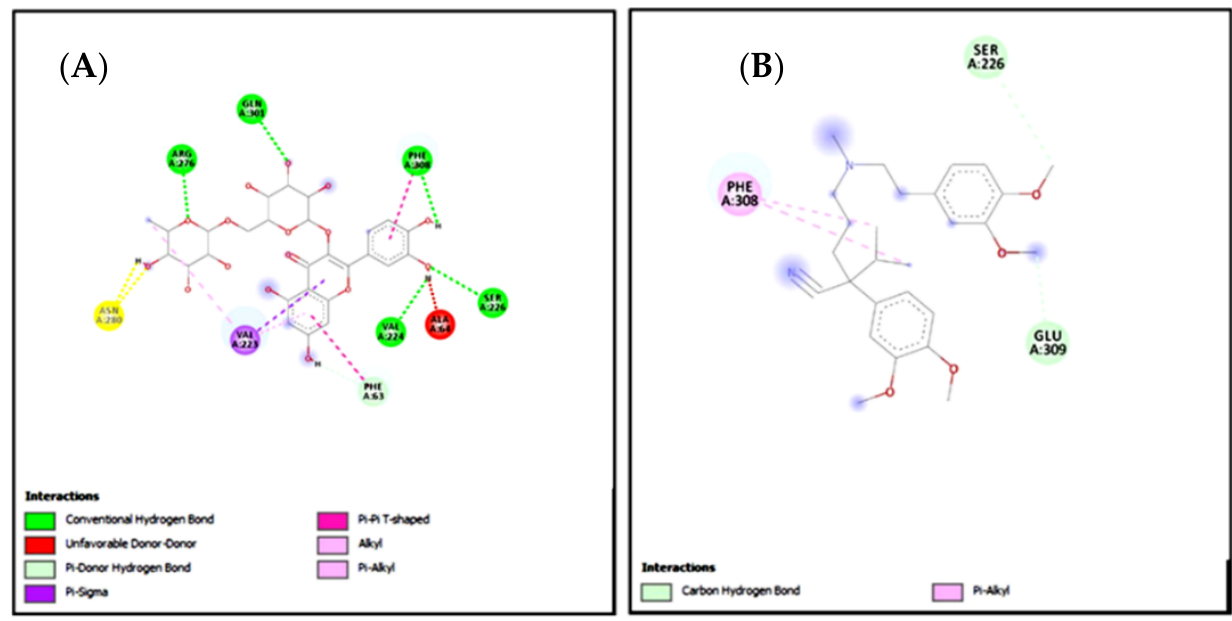
Figure 17. ( A,B ) represents 2D interactions of rutin and verapamil against the target: Voltage-gated L-type calcium channels respectively, evaluated through Biovia Discovery Studio 2016.